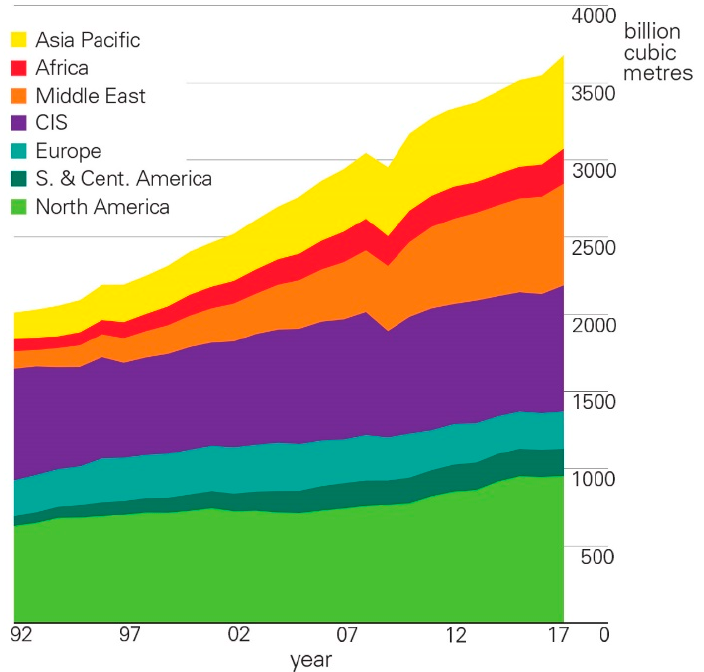
Figure 1. Consumption of natural gas by region in billion cubic meters 1992–2017 [10].